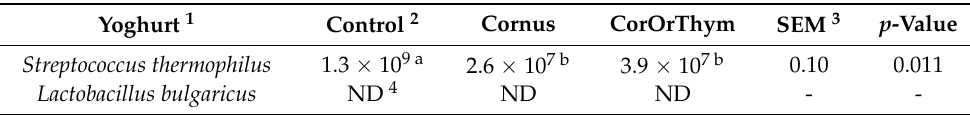
Table 9. Effects of diet supplementation with cornus extract and oregano and thyme essential oils on yoghurt bacteria populations.